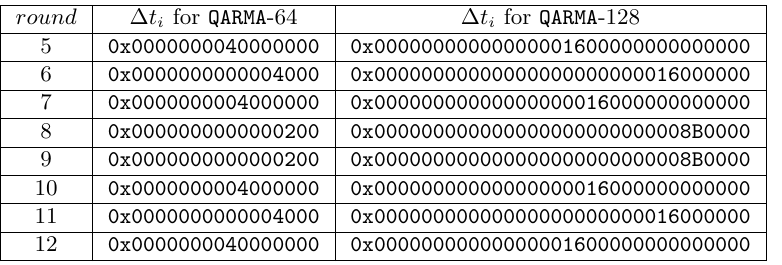
Table 4: Difference of Round Tweak for 8-Round QARMA with ( in 0 , in 1 ) = (0 , 5) round ∆ t i for QARMA -64 ∆ t i for QARMA